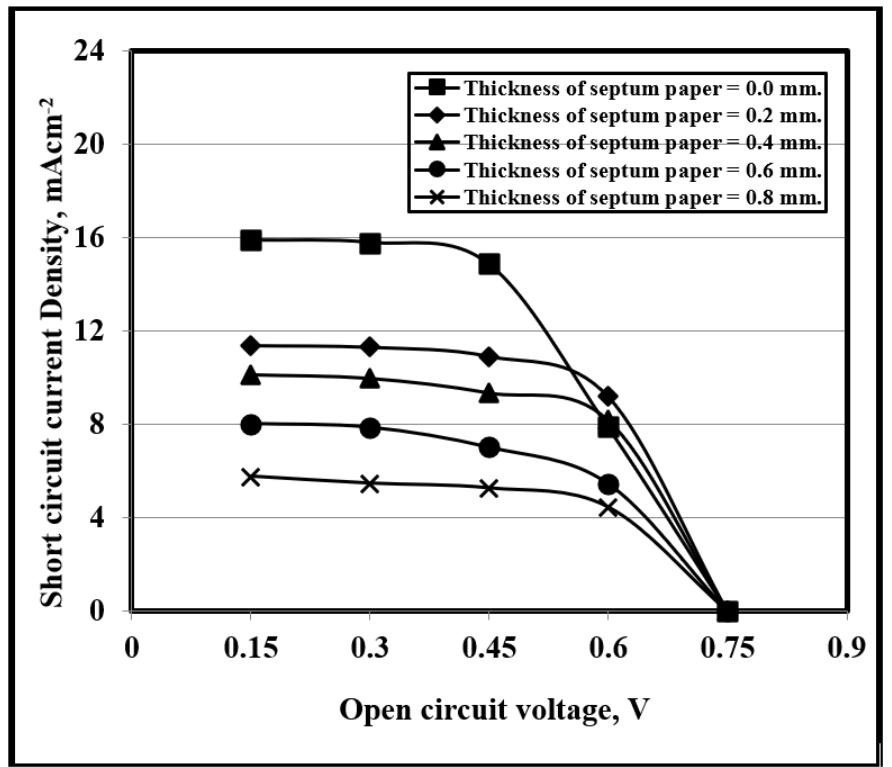
Figure 13. I-V curves of a nZnO-Chl/32wt%PNC DSSC under different sunlight intensities. These results confirm that the proposed DSSC with 32% PNC is suitable for outdoor applications. The different sunlight intensity effect on cell efficiency is as follows according to Amadi et al. [106] and listed in Table 2